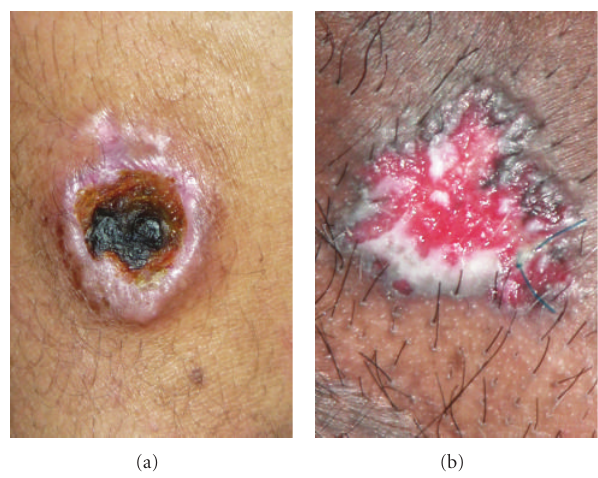
Figure 1: GCT presented with a solitary large ulcerative lesion on the arm (a) and scrotum (b).